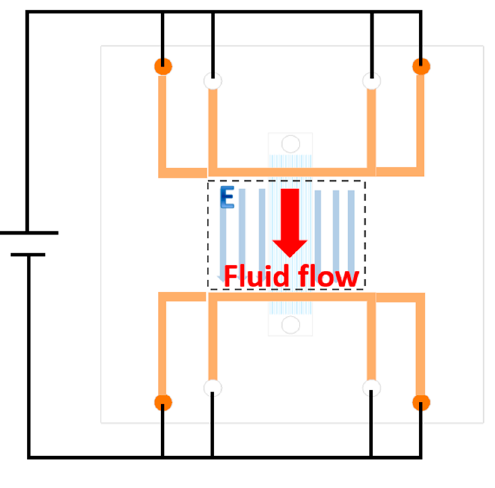
Figure 3. Working Figure 3. Working principle. Figure 3. Working principle.